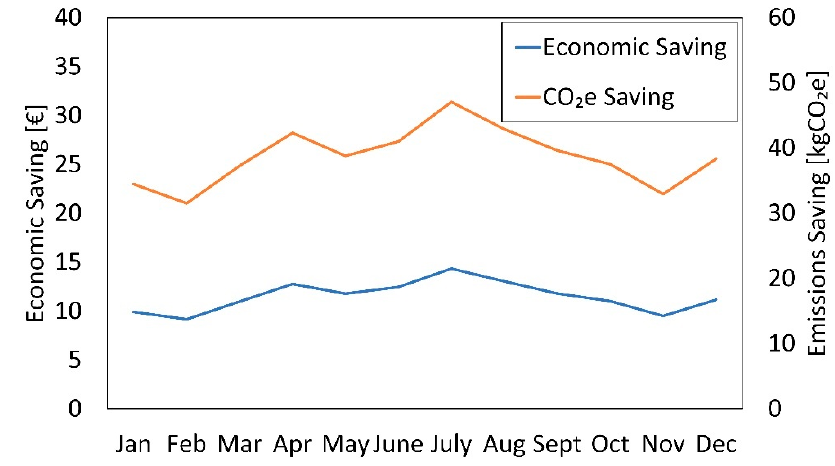
Figure 12. Monthly economic and CO 2 ,e emissions savings provided considering the multiple-deliveries scenario. The refrigerated van represents the reference solution without the PV panels installed.